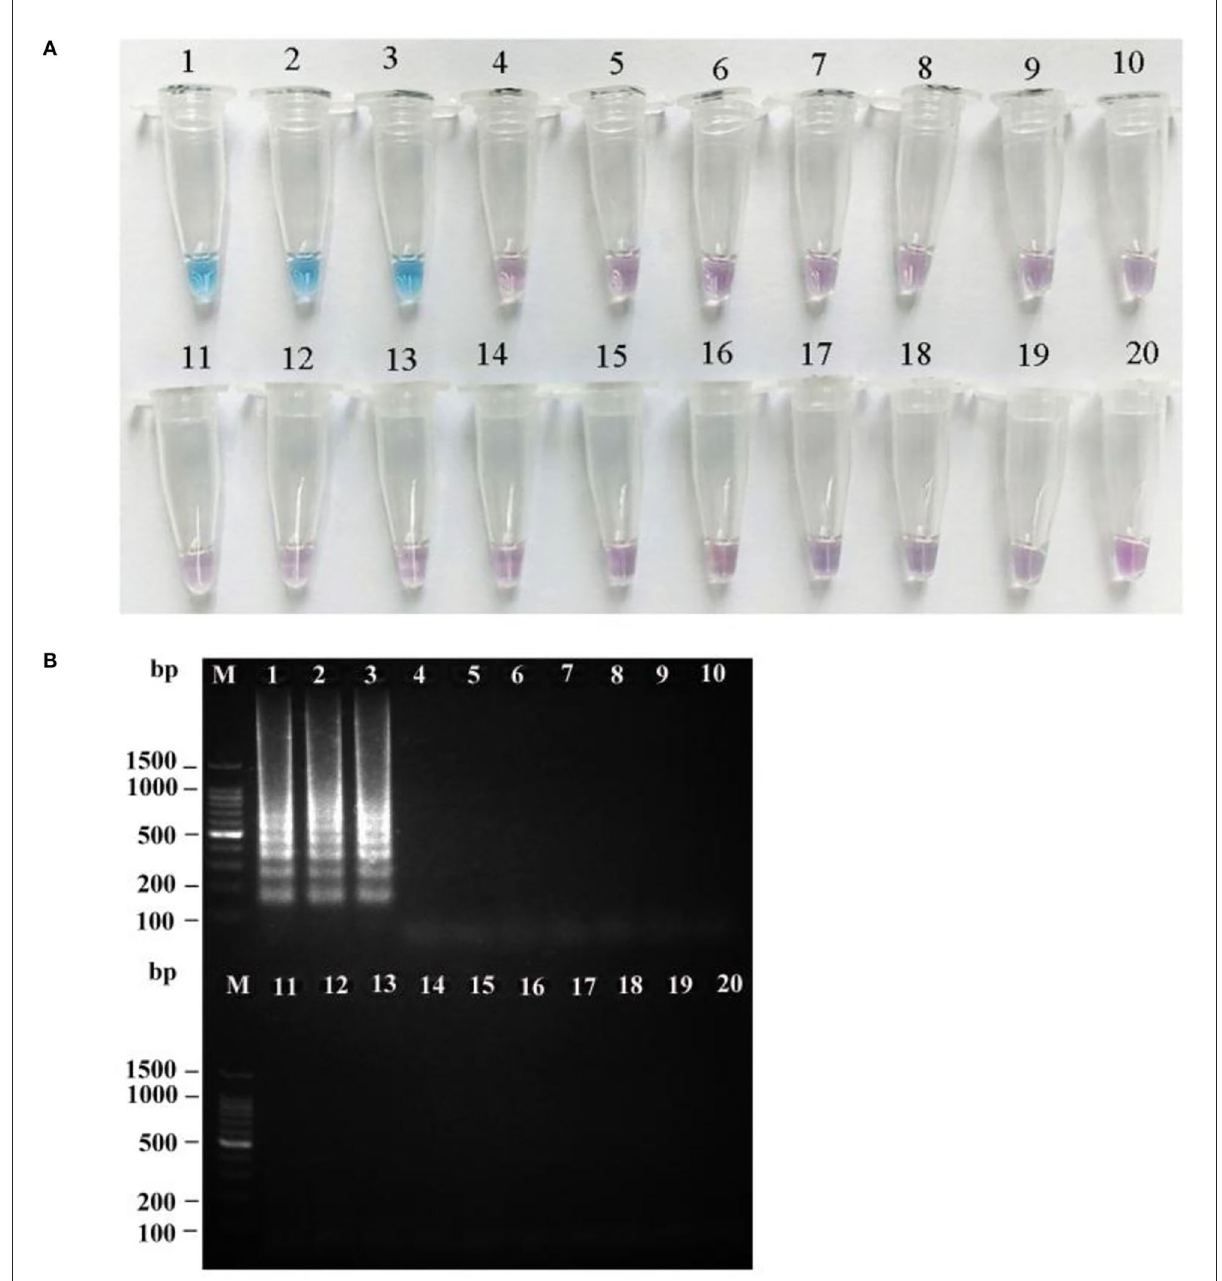
FIGURE7 Specificity of the LAMP assay for R. japonica . HNB dye staining of LAMP products (A) and agarose gel electrophoresis of LAMP products (B) . M: 100 bp ladder; lanes 1–3: R. japonica ; lane 4: R. subnigricans ; lane 5: R. nigricans ; lane 6 : R. densifolia ; lane 7: R. crustosa ; lane 8: R. crustosa ; lane 9: R. mairei ; lane 10: R. pulchra ; lane 11: R. chiui ; lane 12: R. risigallina ; lane 13: R. virescens ; lane 14: R. zvarae ; lane 15: R. griseocarnosa ; lane 16: R. senecis ; lane 17: R. sp.; lane 18: R. rosea ; lane 19: R. cyanoxantha ; and lane 20: ddH 2 O (blank